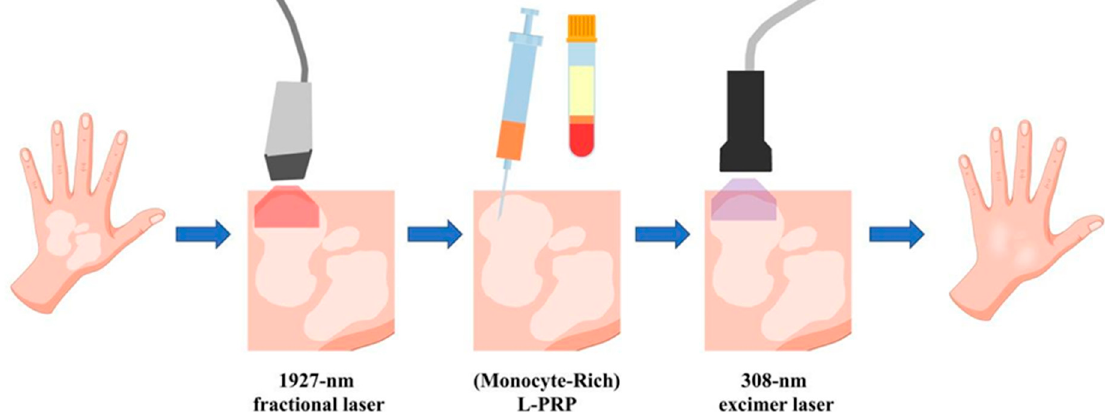
Figure 2. Scheme of the steps carried out in a complete vitiligo treatment session. L-PRP means leukocyte-rich PRP. Vector files downloaded from